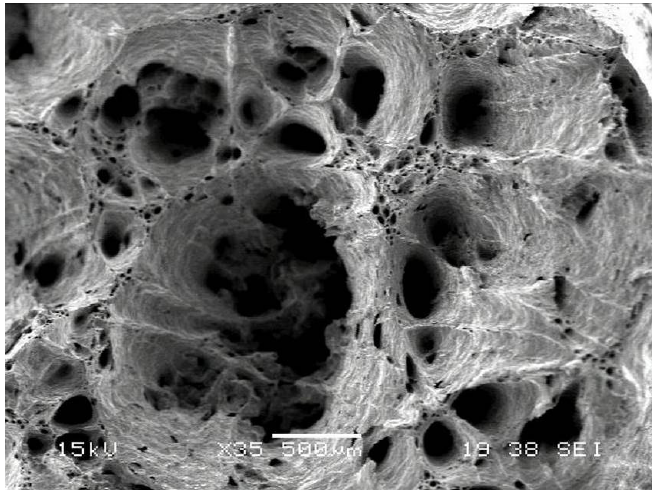
Figure 4. SEM image of fracture surface for the specimen tested at 1100 °C.